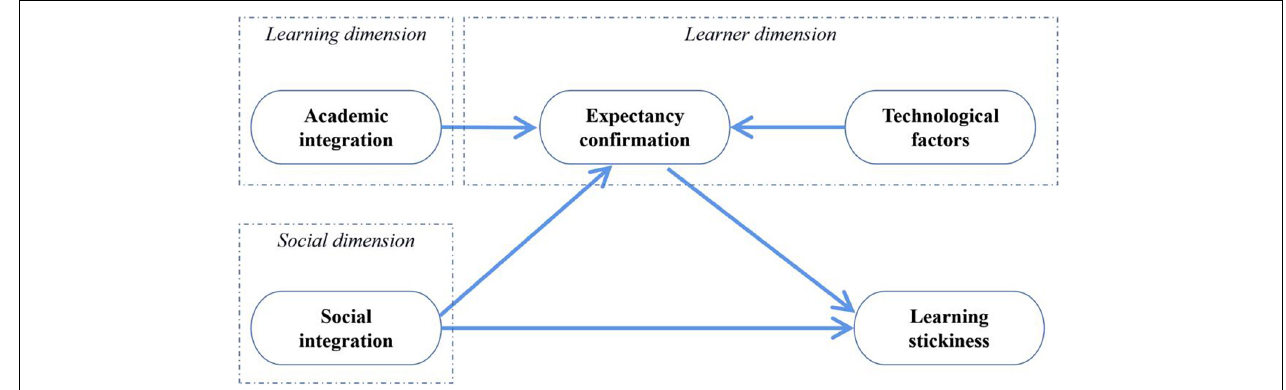
FIGURE 1 | The theoretical model of present